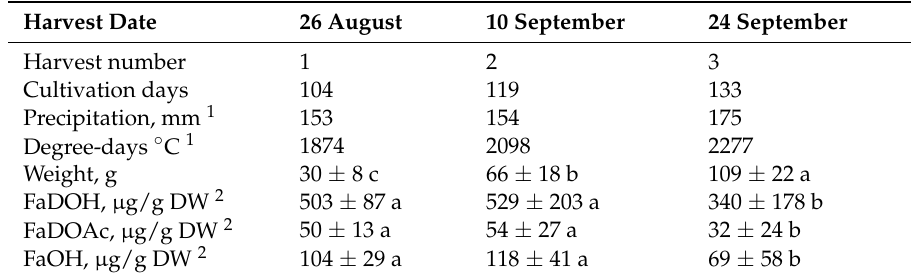
Table 1. Sampling date, sum of precipitation and temperature at the time of sampling and mean traits of carrot samples harvested on three different occasions in 2006. Means within the same row followed by different letters are significantly different according to one-way ANOVA with Duncan’s post-hoc test ( p < 0.05). n =